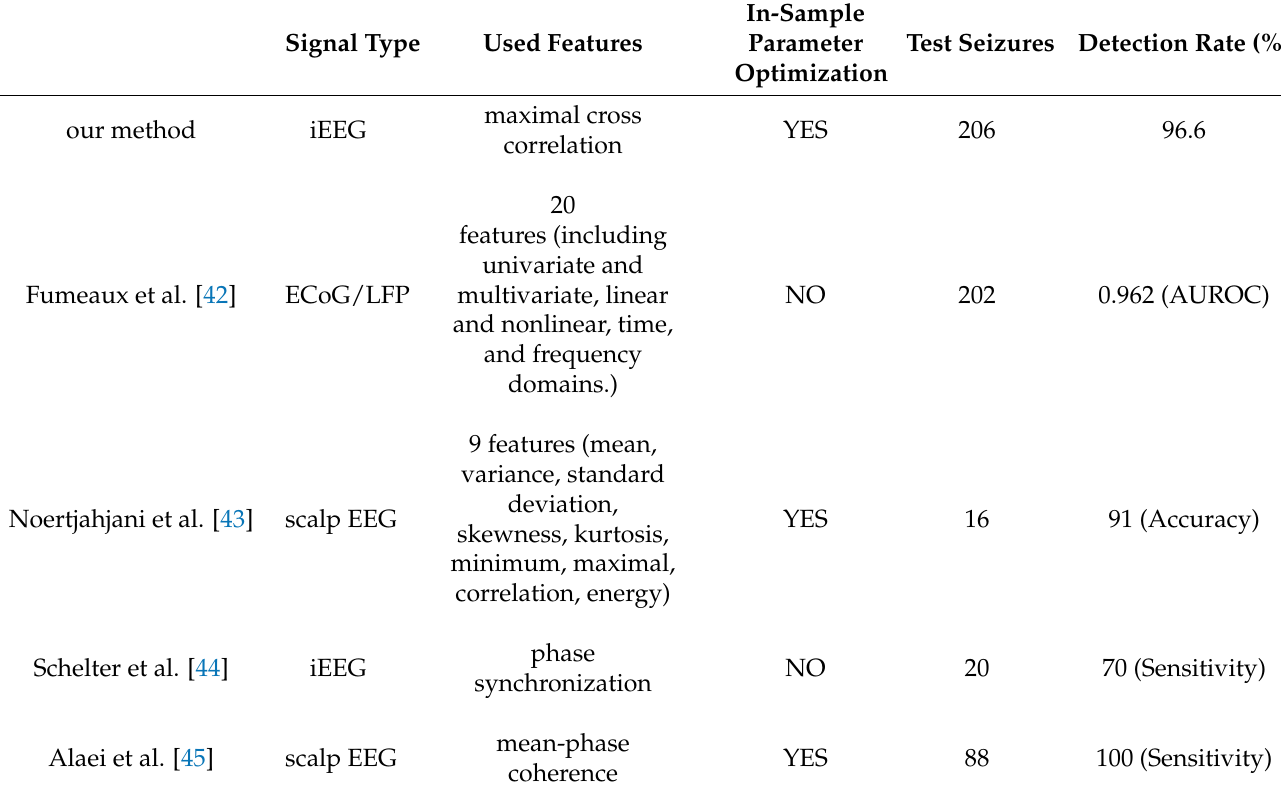
Table 5. Comparison with previous